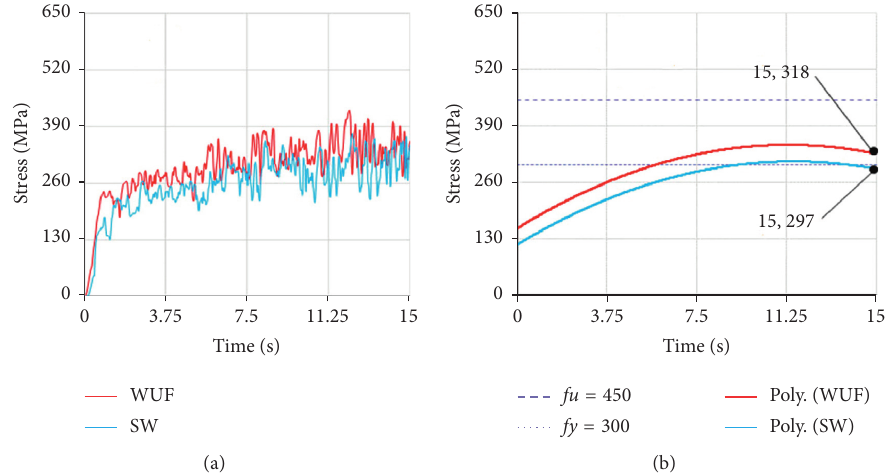
Figure 17: The stress at the weld area of the beam to the column connection in the connection panel zone (a) and the weld area of the beam to the column connection